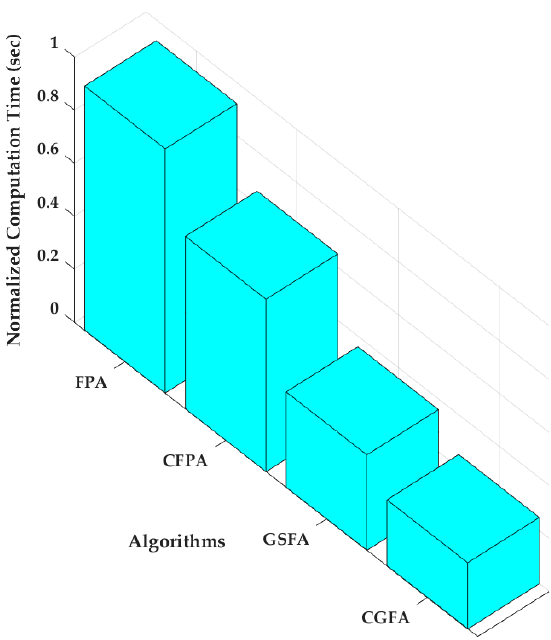
Figure 11. Normalized computation time for IEEE 119-bus system for all scenarios.